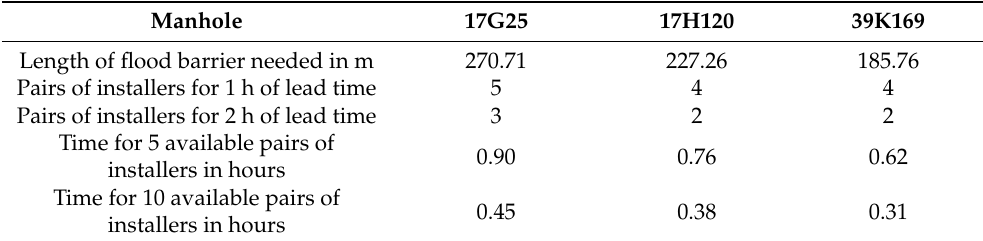
Table 4. Time and people needed for the instalment of flood protection Table 3. Damage estimation for manholes with and without flood protection barriers for all return periods in Euros [€].